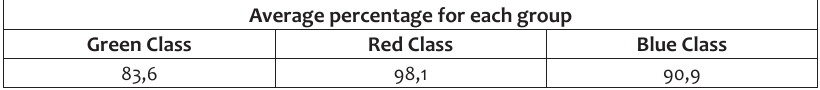
Table 2: Children’s understanding of environmental phenomena.